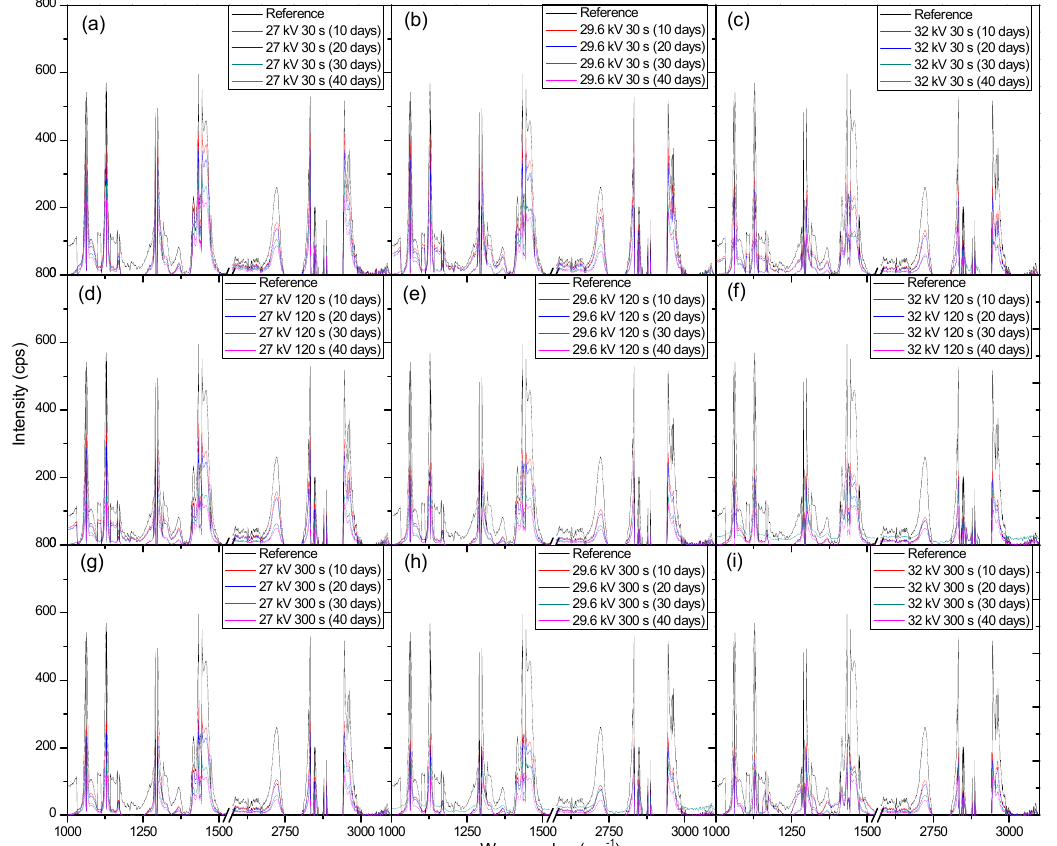
Figure 13. Raman spectroscopy measurements of plasma treated LDPE after their introduction into the bacterial broth to obtain biodegradation. The operating gas for plasma discharge was ambient air. ( a – i ) show how exposure time and applied voltage during plasma treatment impact the degradation process of LDPE. ( a – c ), ( d – f ), and ( g – i ) show how the changes in voltage impact the degradation of LDPE while maintaining a constant treatment time. ( a , d , g ), ( b , e , h ), and ( c , f , i ) show how the changes in treatment time impact the degradation of LDPE while maintaining a constant applied